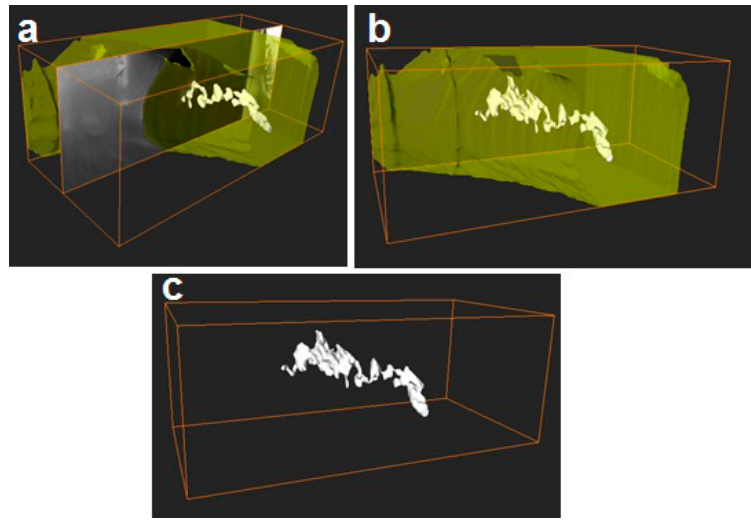
Figure 3. ( a ) The side view of 3D reconstructions of PCL fiber 1 (in semi-transparent yellow) and Pd nanoparticles (in white), including the SEM image (obtained from FIB sectioning) in the middle of the reconstruction, ( b ) 3D reconstruction of PCL fiber 1 with Pd nanoparticles inside, ( c ) 3D reconstruction of particles only inside of PCL fiber 1. The binding box size for this reconstruction had the following dimensions 3.105 × 1.185 × 1.526 um.